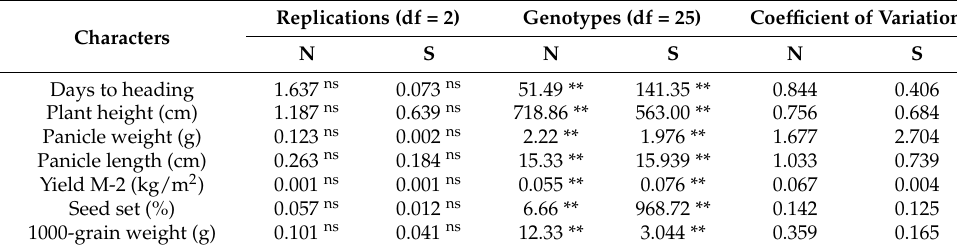
Table 2. Combined mean square analysis for yield and its component characters.